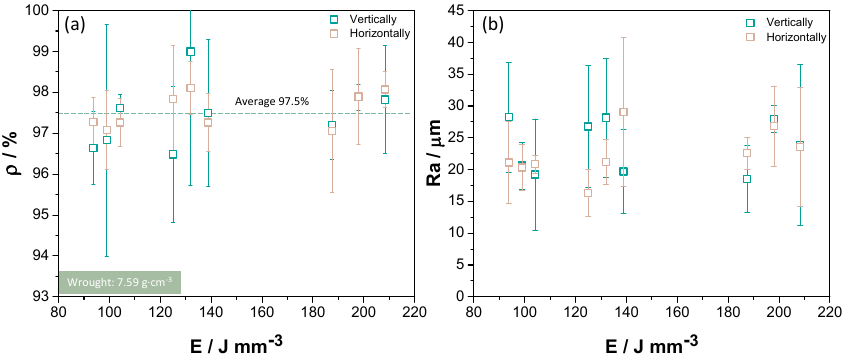
Figure 3. ( a ) Relative density and ( b ) surface roughness as a function of volumetric laser energy for samples fabricated vertically and horizontally.